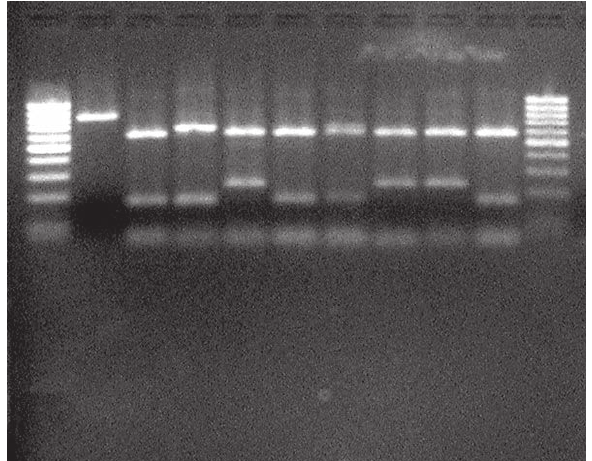
Fig. 4. ITS-RFLP patterns of I. jamaicensis using the restriction endonuclease Hae III. Lane 1 and 10, size marker (high-intensity: 500 and 1000 bp); lane